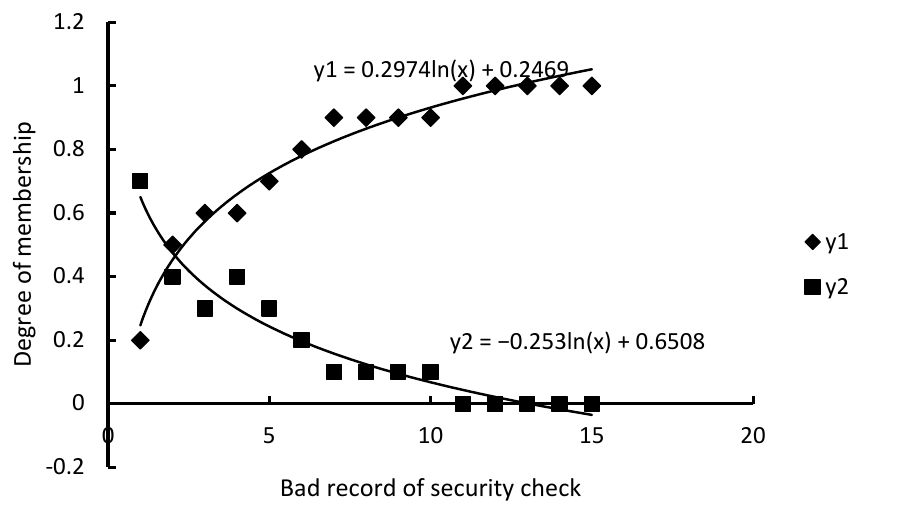
Figure A25. Single factor evaluation for the index of awards (one and more times).